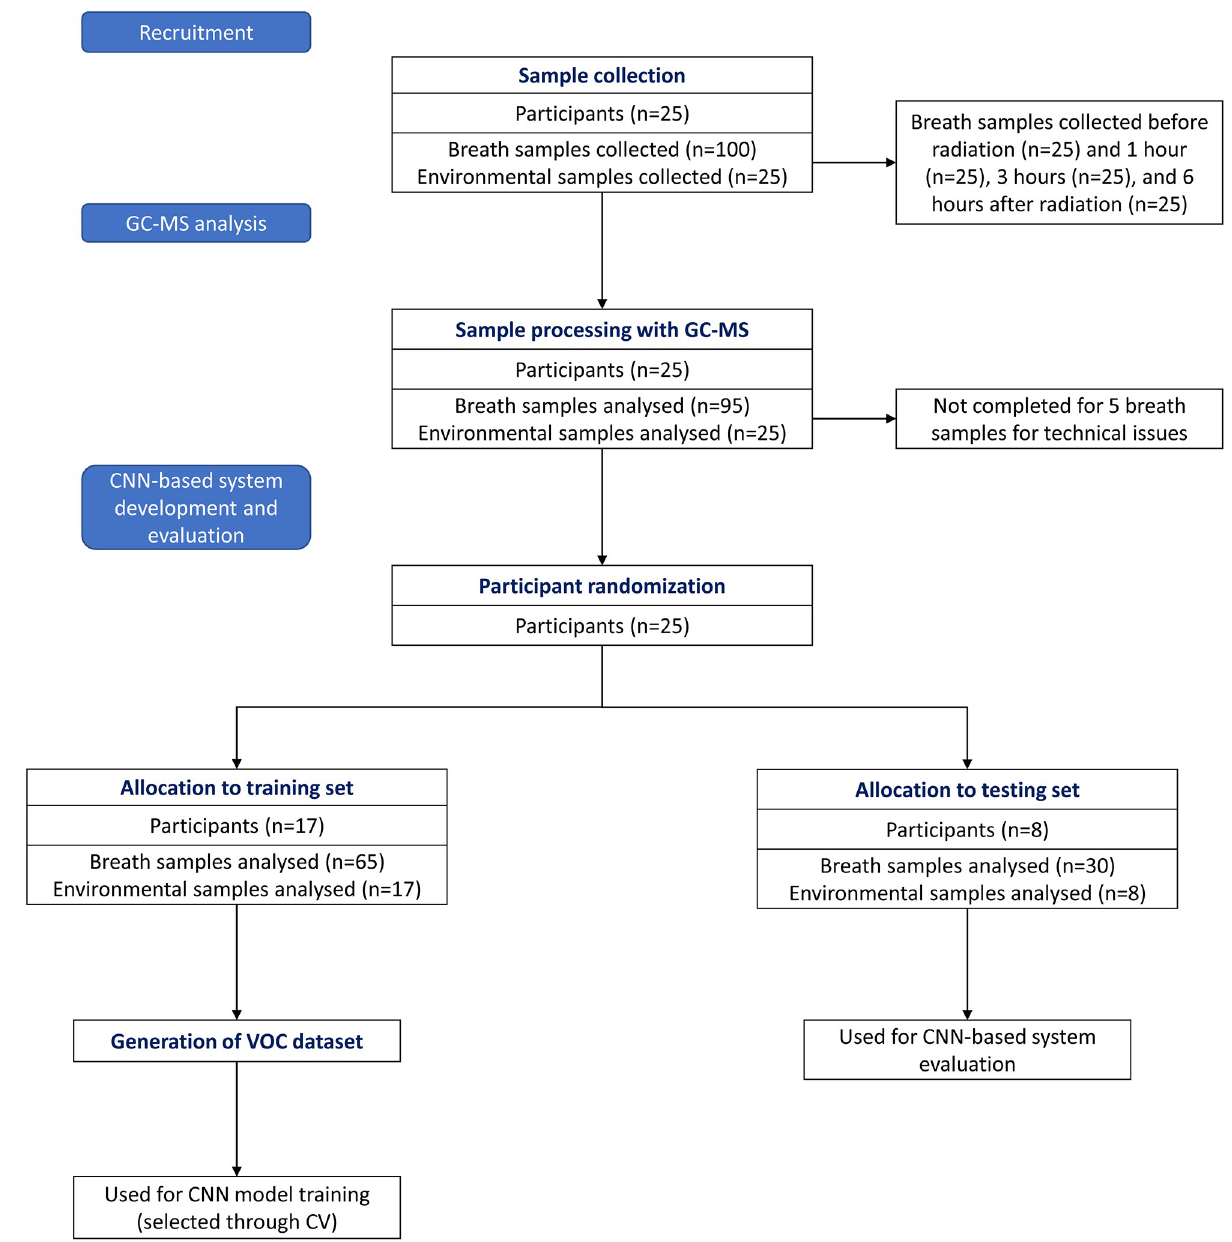
Fig 3. Sample and data flow through the